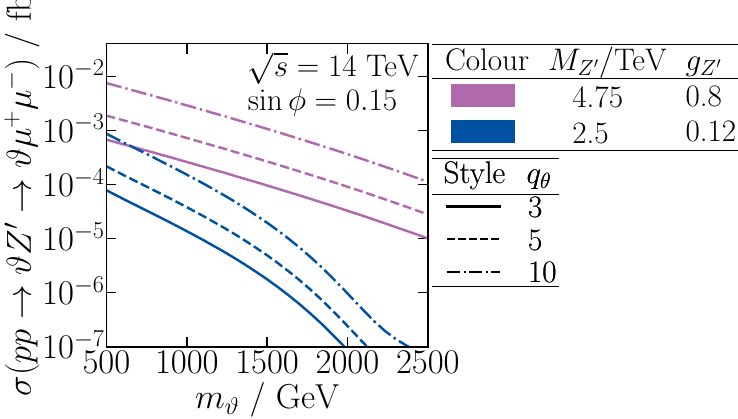
Figure 11. Flavonstrahlung cross-sections for 14 TeV pp collisions but with a variable flavon charge. The charge q θ takes on values 3, 5 and 10, represented by solid, dashed and dash-dotted lines, respectively. The line colours represent different points in the M Z 0 — g Z 0 plane and are congruent with the colours of the stars in figure 10.